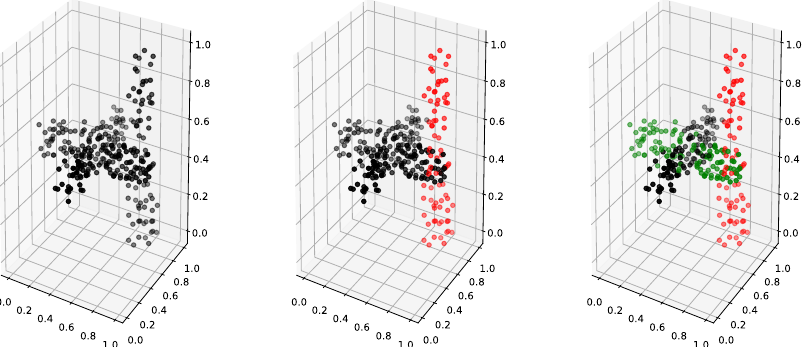
Figure 8. Cross dataset from [36]. The first plot gives the unlabeled observations; the second plot gives the true two-cluster clustering; and the third plot gives the ideal three-cluster